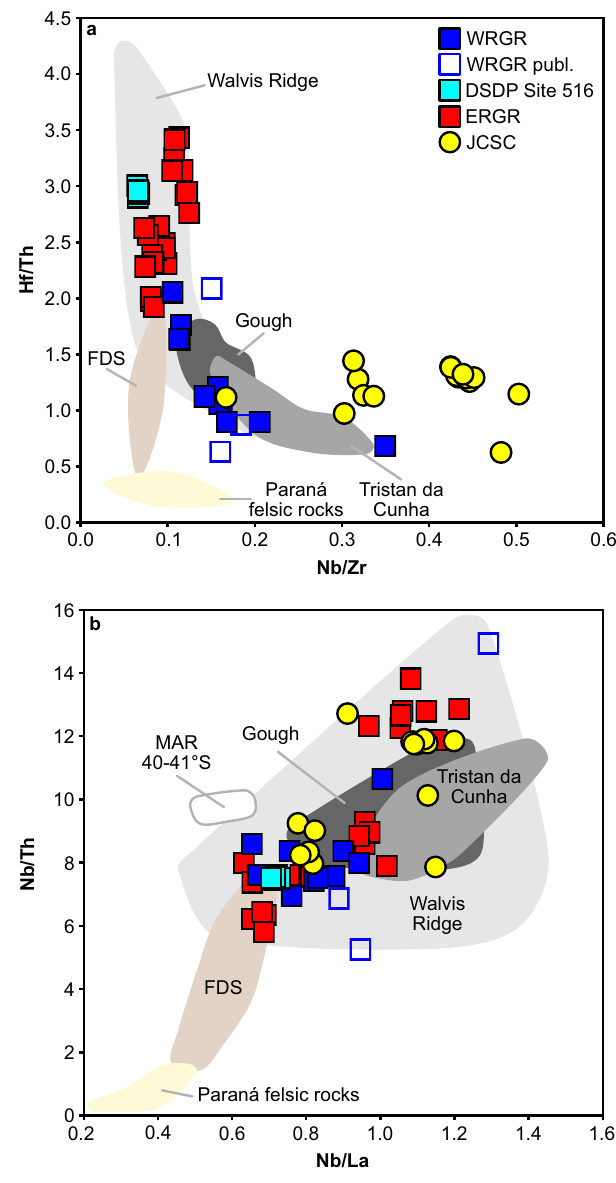
Fig. 5 Trace element ratios showing geochemical differences between the Eastern Rio Grande Rise (ERGR) and Western Rio Grande Rise (WRGR). Trace element variations of a Nb/Zr versus Hf/Th, and b Nb/La versus Nb/ Th are shown. For comparison lava fl ows from the Walvis Ridge 15,52 , and the ocean islands of Tristan da Cunha and Gough 53 – 56 are shown. Further, we considered geochemical compositions of previously dredged samples from the WRGR 18,20 , glasses from South Atlantic Mid-Ocean Ridge Basalt (MORB) 57 and crustally contaminated lavas from the Florianopólis Dyke Swarm 36 (FDS) for comparison. The fi eld of the Paraná felsic rocks